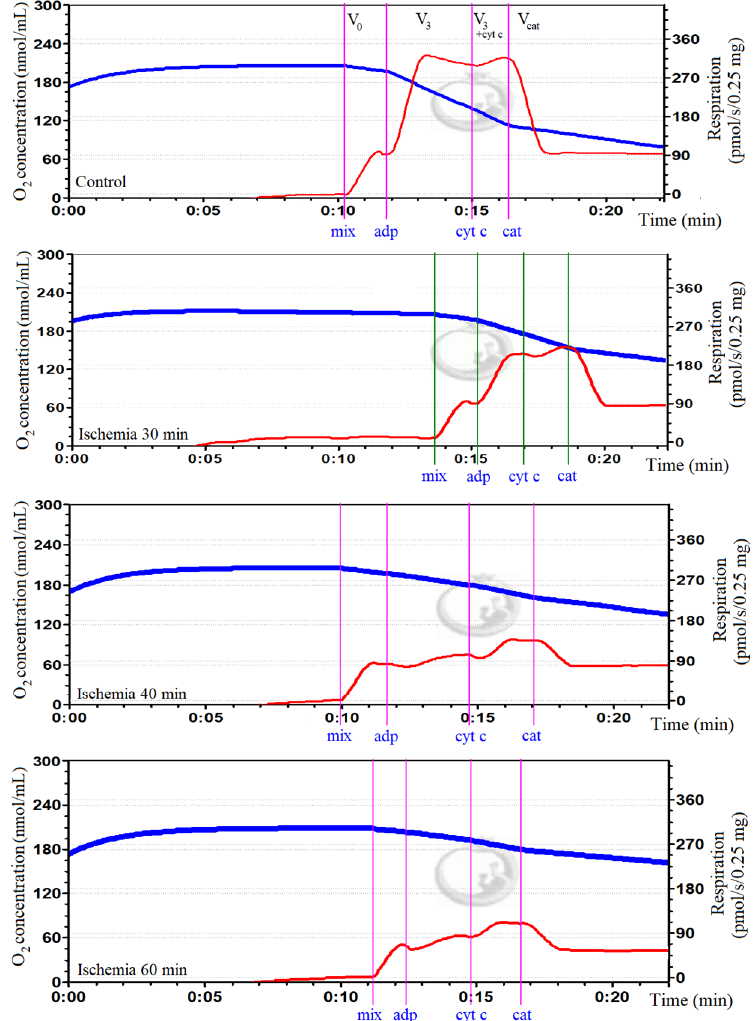
Figure 1. Oxygen consumption in kidney mitochondria in control and ischemia groups. In the curves, the blue trace represents oxygen concentration (nmol/mL), and the red trace represents oxygen flux (pmol/s/0.25 mg mitochondrial protein). V 0 : respiration rate in the presence of 0.5 mg/mL of mitochondria (mix) and substrates, 5 mM glutamate and 5 mM malate; V 3 : maximal respiration rate after adding 2 mM ADP; V 3+cytc : respiration rate after adding 32 µ M cytochrome c; V cat : respiration rate after adding 0.12 mM carboxyatractyloside. It was observed that mitochondrial respiration was diminished in all ischemia groups comparing to control.